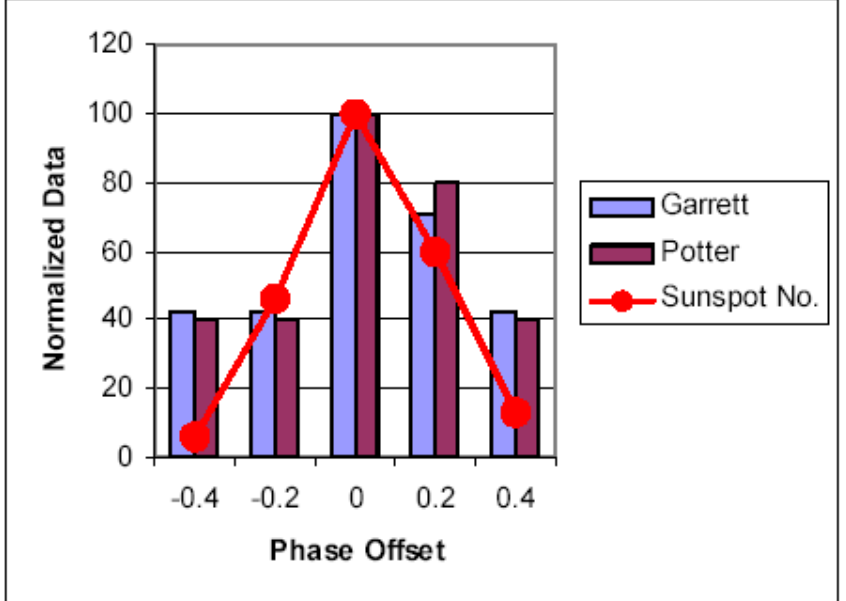
Figure 10. Distribution of Influenza Pandemics (according to different authors) as a function of phase offset from solar activity maximum. Data are normalized for a maximum of 100. The solar activity minimum lies at a phase offset of ±0.5. The activity maximum is at a phase offset of 0. The data from Garrett (1994) are shown in blue; those from Potter (1998) in violet. Sunspot Number is shown in red. (From [86], reproduced by the kind permission of Dr.